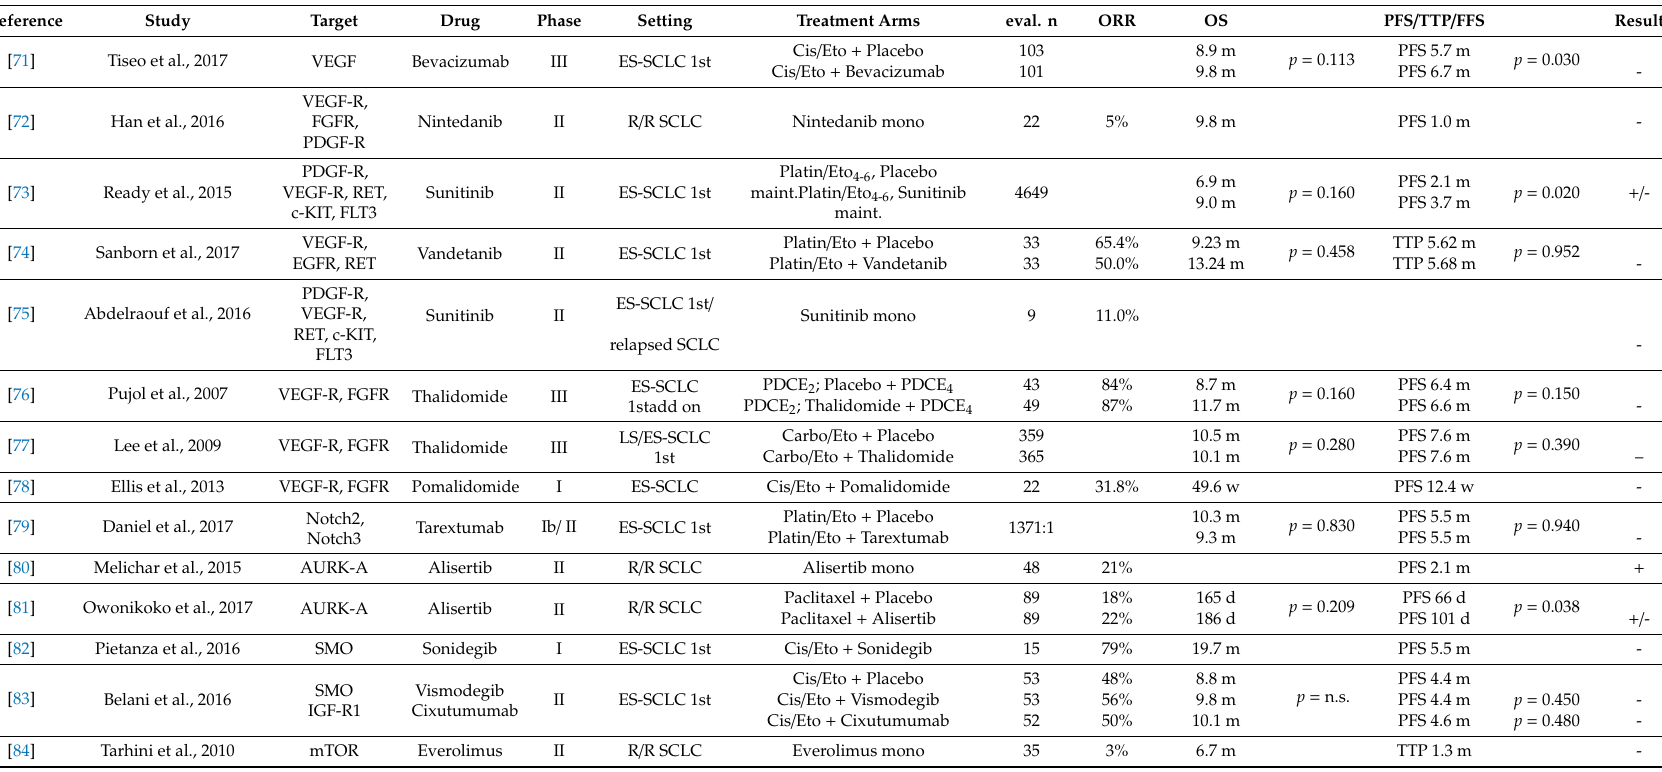
Table 3. ES-SCLC = extensive-stage SCLC, LS-SCLC = limited-stage SCLC, R / R SCLC = refractory / relapsed SCLC, 1st = 1st line, Cis = cisplatin, Carbo = carboplatin, Platin = cisplatin or carboplatin, Eto = etoposid, PDCE = cisplatin, 4’-epidoxorubicin, cyclophosphamide, etoposide, CTx = chemotherapy, Cyc = cyclophosphamide, m = months ( / monthly), w = weeks( / weekly), d = days( / daily), maint. = maintenance, ORR = objectiveresponserate(in%), OS = overallsurvival, PFS = progression-free survival, TTP = time to progression, FFS = failure-free survival, n.s. = not significant, ref. = reference arm; Results: + positive trial, +/ − indi ff erent trial, - negative trial, – harmful